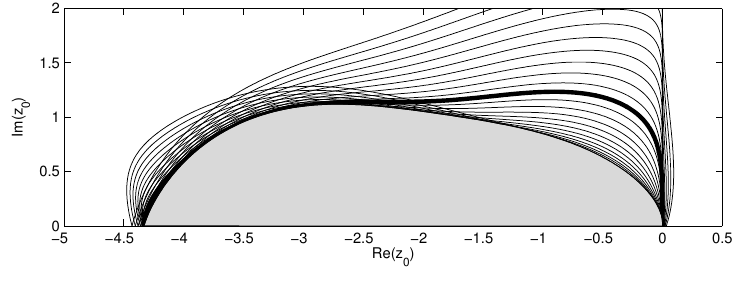
Figure 3. Stability regions S π/ 2 ,y , y = − 2 . 0 , 1 . 8 ,..., 2 . 0 (thin lines), S π/ 2 (shaded √ region), and S E (thick line) for λ = (2 − 2) / 2, c 2 = 1 and β 21 ≈ 2 . 61. On Fig. 3 we have plotted stability regions S for y = − 2 . 0 , − 1 . 8 , . . . , 2 . 0 π/ 2 ,y (thin lines), stability region S (shaded region), and stability region S E (thick π/ 2 √ line), corresponding to c 2 = 1, λ = (2 − 2) / 2, and β 21 ≈ 2 . 61. We can see that S contains a significant part of S E π/ 2